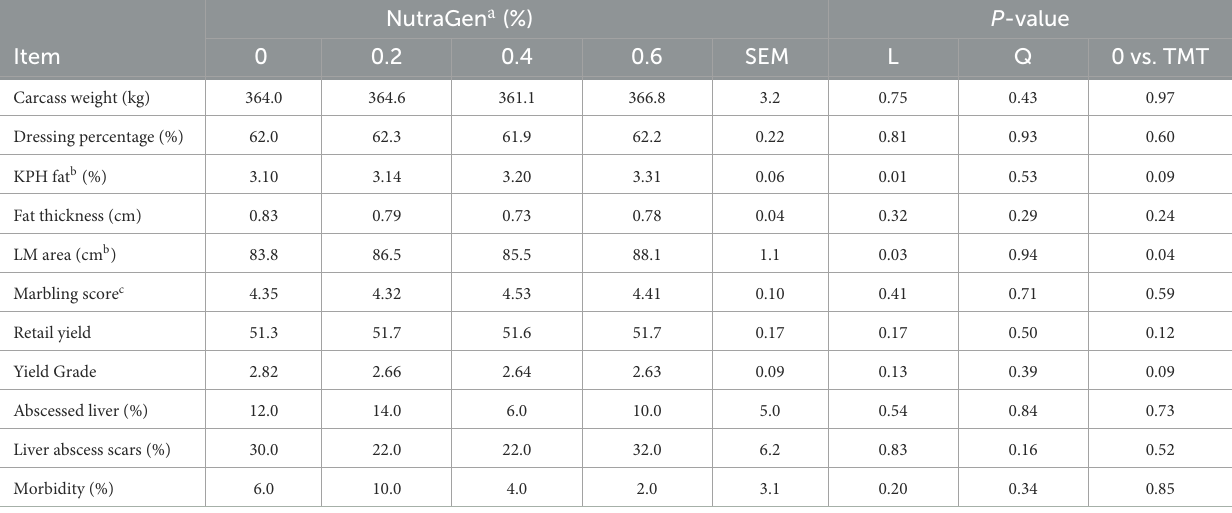
(24). Duodenal flow and fecal excretion of DM were determined based on marker ratio using chromic oxide. Microbial organic matter (MOM) and nitrogen (MN) leaving the abomasum were estimated using purines as microbial markers (24). Organic matter (OM) fermented in the rumen is considered equal to OM intake minus the difference between the amount of total OM reaching the duodenum and MOM reaching the duodenum. Feed N